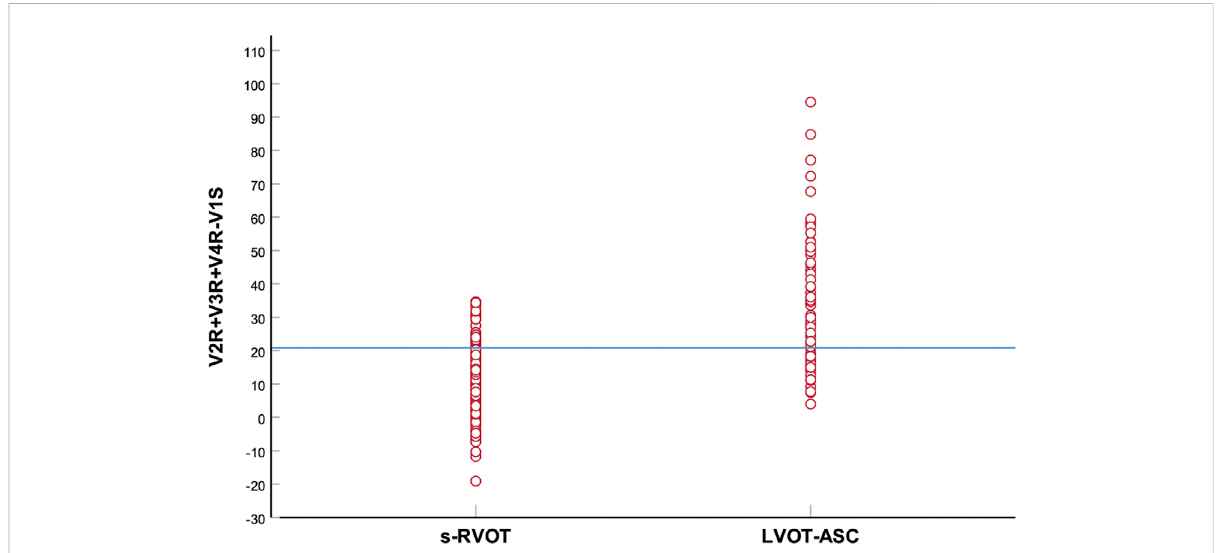
FIGURE 3 Scatter plot of the R-S difference index in the precordial leads of the s-RVOT and LVOT-ASC groups. The blue horizontal line indicates the optimal index cutoff value for differentiating s-RVOT and LVOT-ASC PVCs